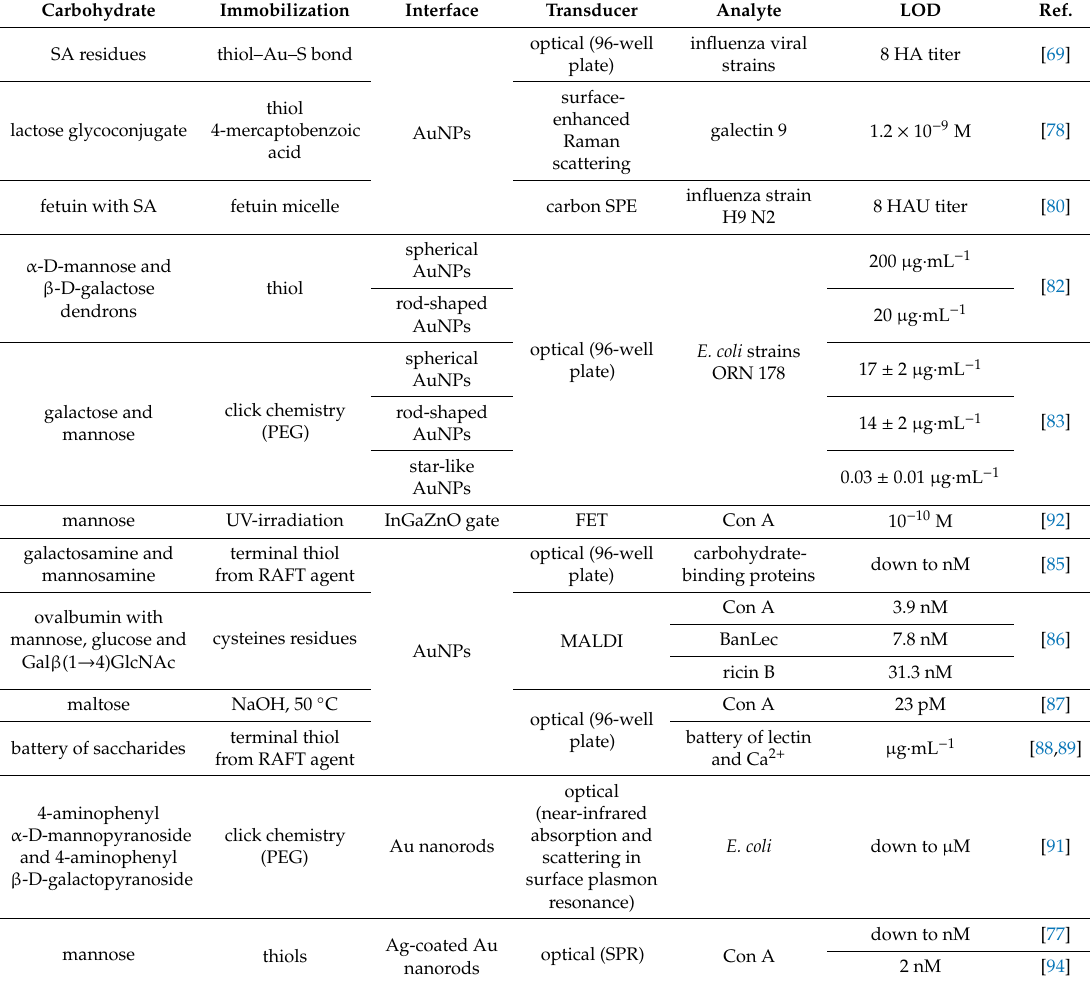
Table 1. AuNP-based glycan nanobiosensors and their